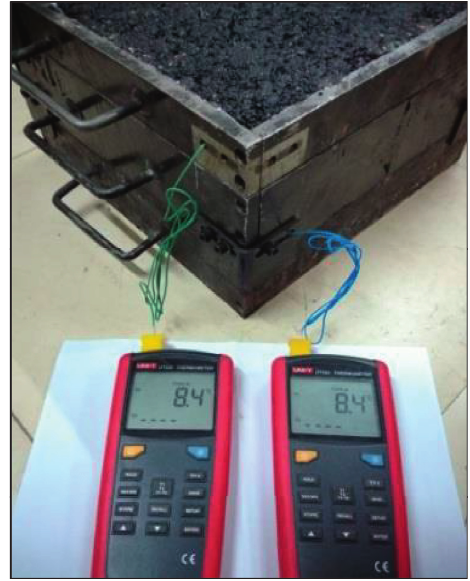
Figure 3: The prepared 18 cm thick specimen.